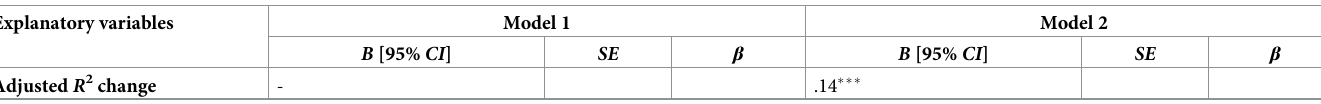
dent predictors of depression in the fully adjusted model. Based on the unique contribution, mindfulness ( β = -.35), living in Chattogram division ( β = -.24), optimism ( β = -.15), age ( β = -.12), completion of a double dose of vaccine ( β = -.10), and having a history of mental illness ( β = .10) were found the strongest predictors of depression.